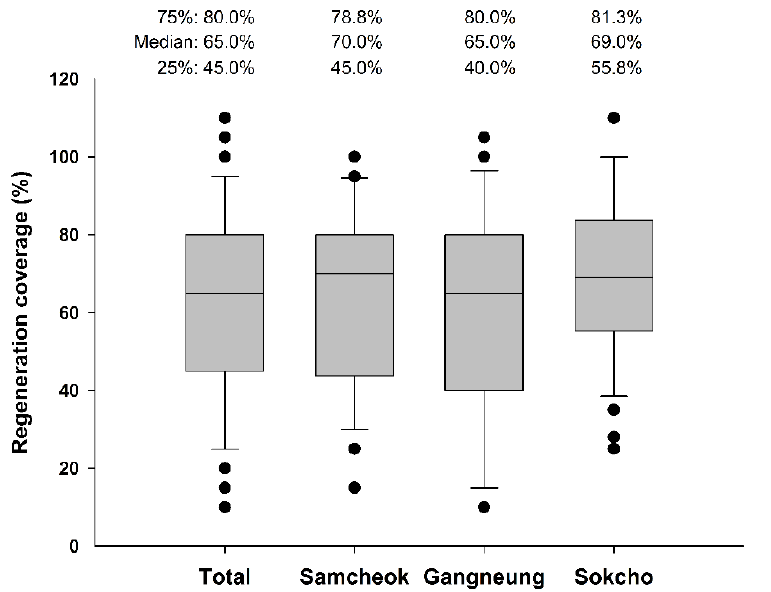
Figure 2. Postfire coverage of initial stands. The first (25%), second (median), and third (75%) quartiles are indicated above each box. Fifty, 66, and 36 plots were investigated in Samcheok, Gangneung, and Sokcho, respectively, resulting in a total of 152.